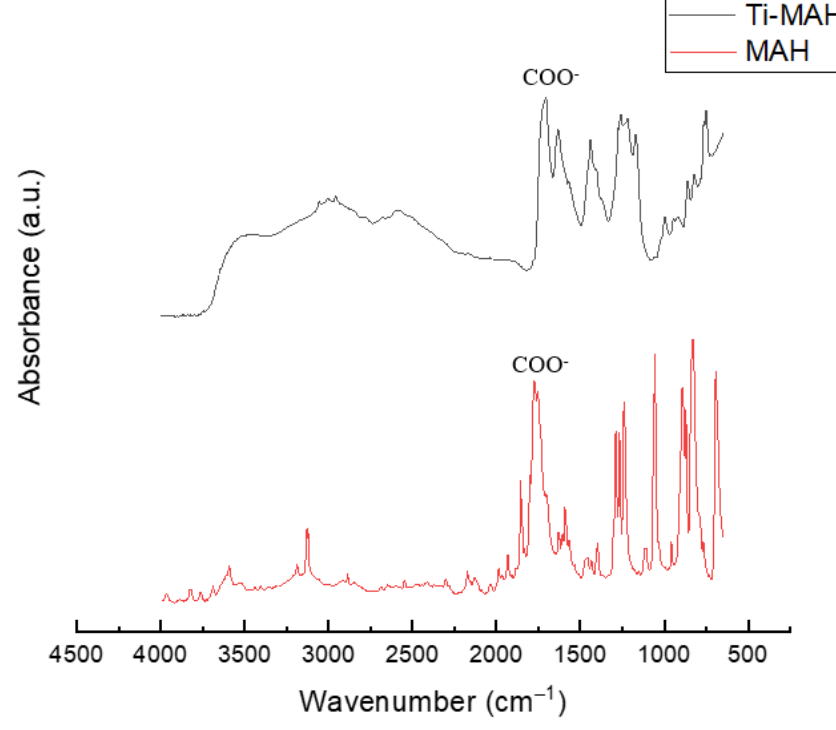
Figure 1. FTIR analysis of MAH and Ti-MAH.